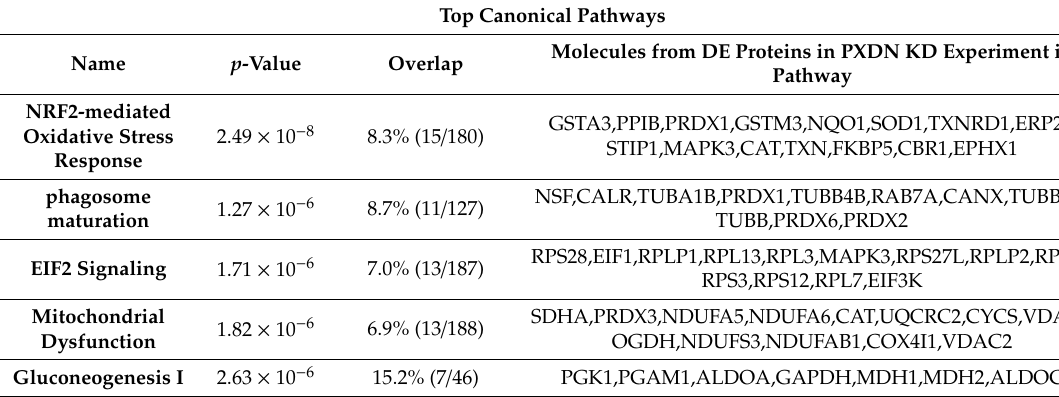
Table 2. Top canonical pathways regulated by PXDN. Top Canonical